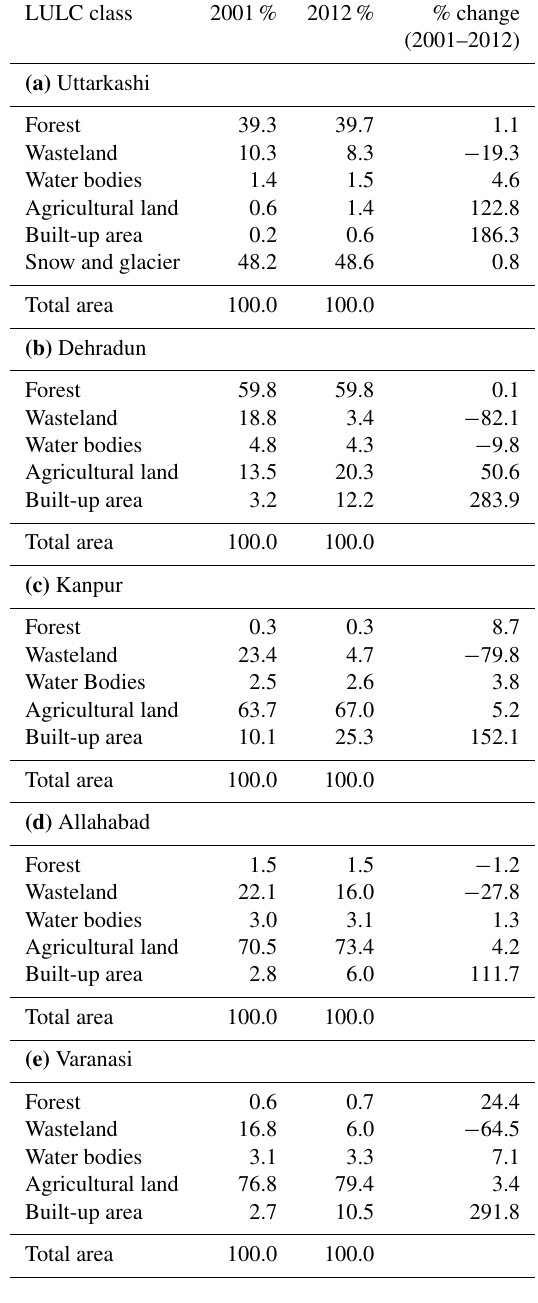
Table 5. Change matrix showing LULC interconversion between the year 2001 and 2012 in Upper Ganga River basin. Figures indi- cate the percentage (%) of basin area.